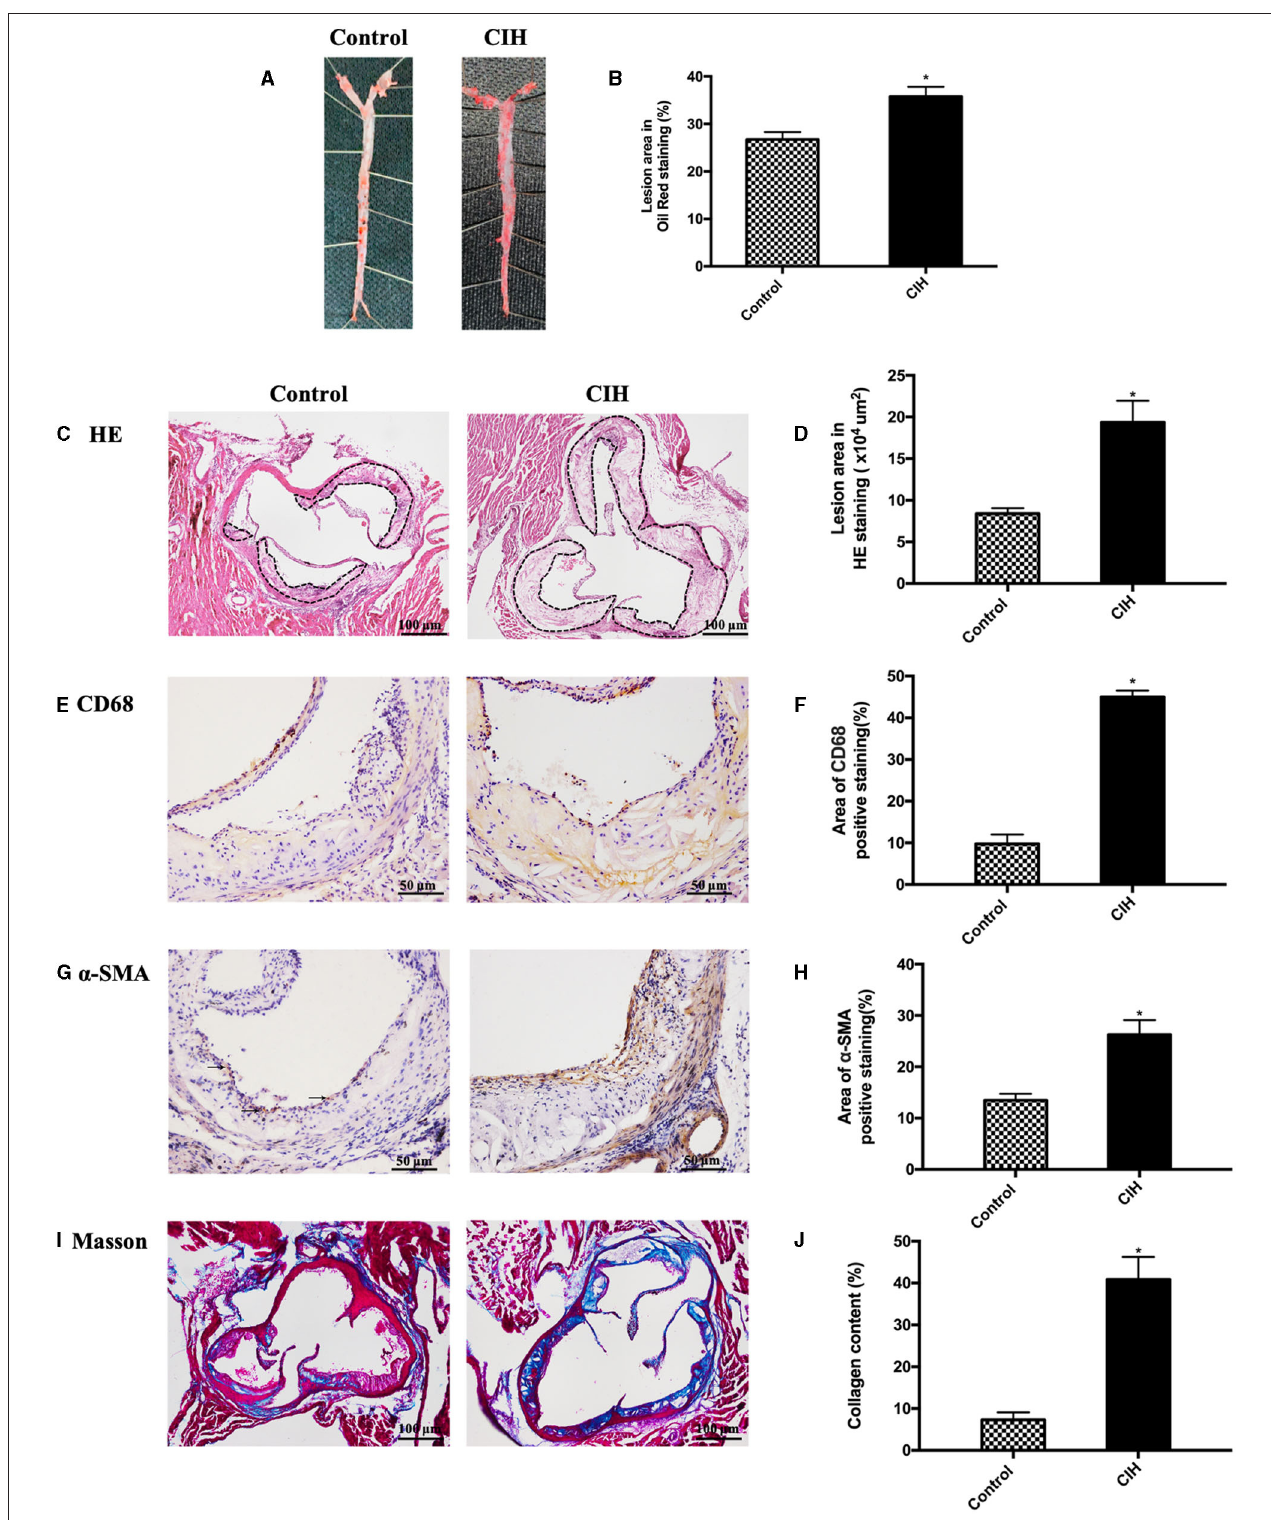
FIGURE 1 | Eight-week exposure of CIH-induced atherosclerosis in ApoE − / − mice. Male ApoE − / − mice exposed to normoxia or CIH grouped as control and CIH group. (A) Representative photographs of whole aorta plaque that were stained with Oil Red O. (B) Plaque area as a percentage of the total area in Oil Red O